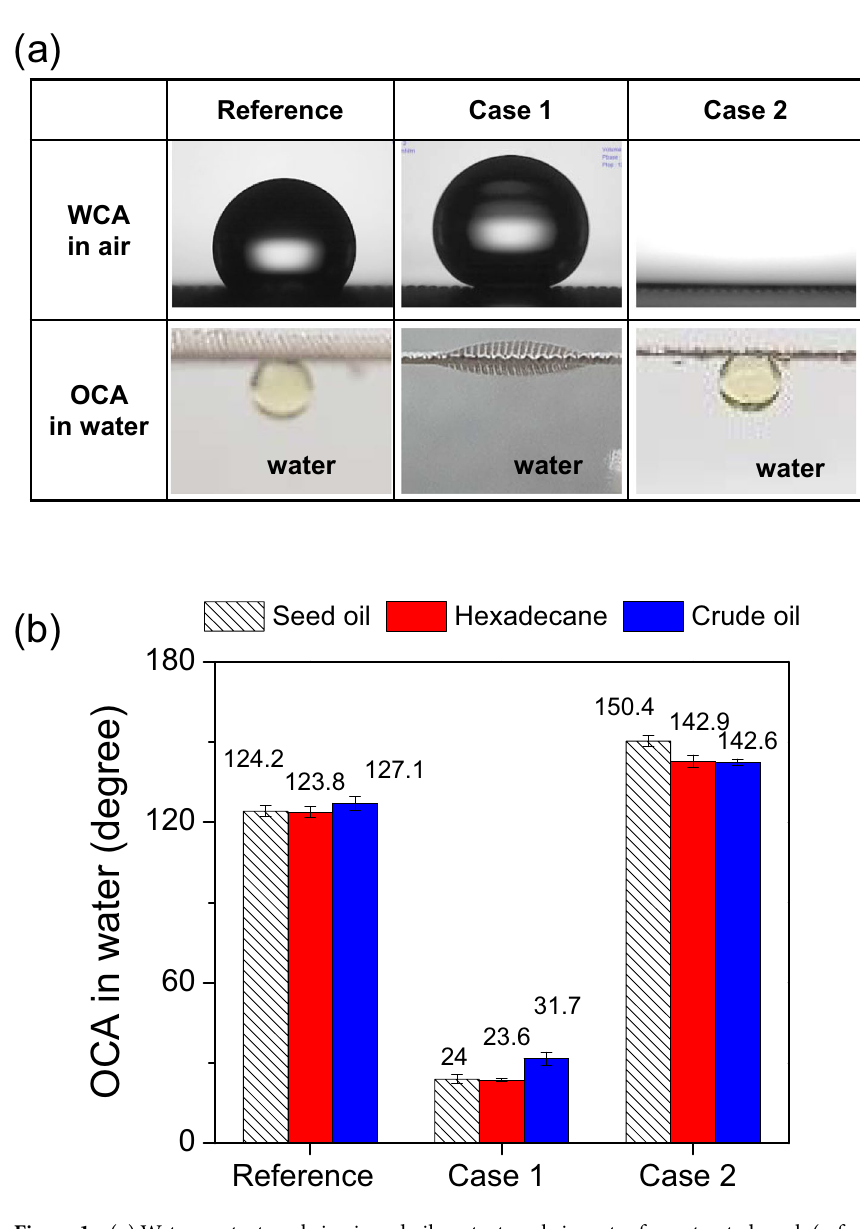
Figure 1. ( a ) Water contact angle in air and oil contact angle in water for untreated mesh (reference), plasma treated mesh with case 1 and case 2. ( b ) Oil contact angle in water on the meshes were also measured with various oils such as seed oil, hexadecane and crude